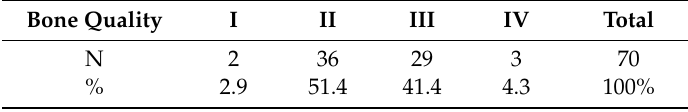
Table 1. Implants distribution according to bone quality assessment.